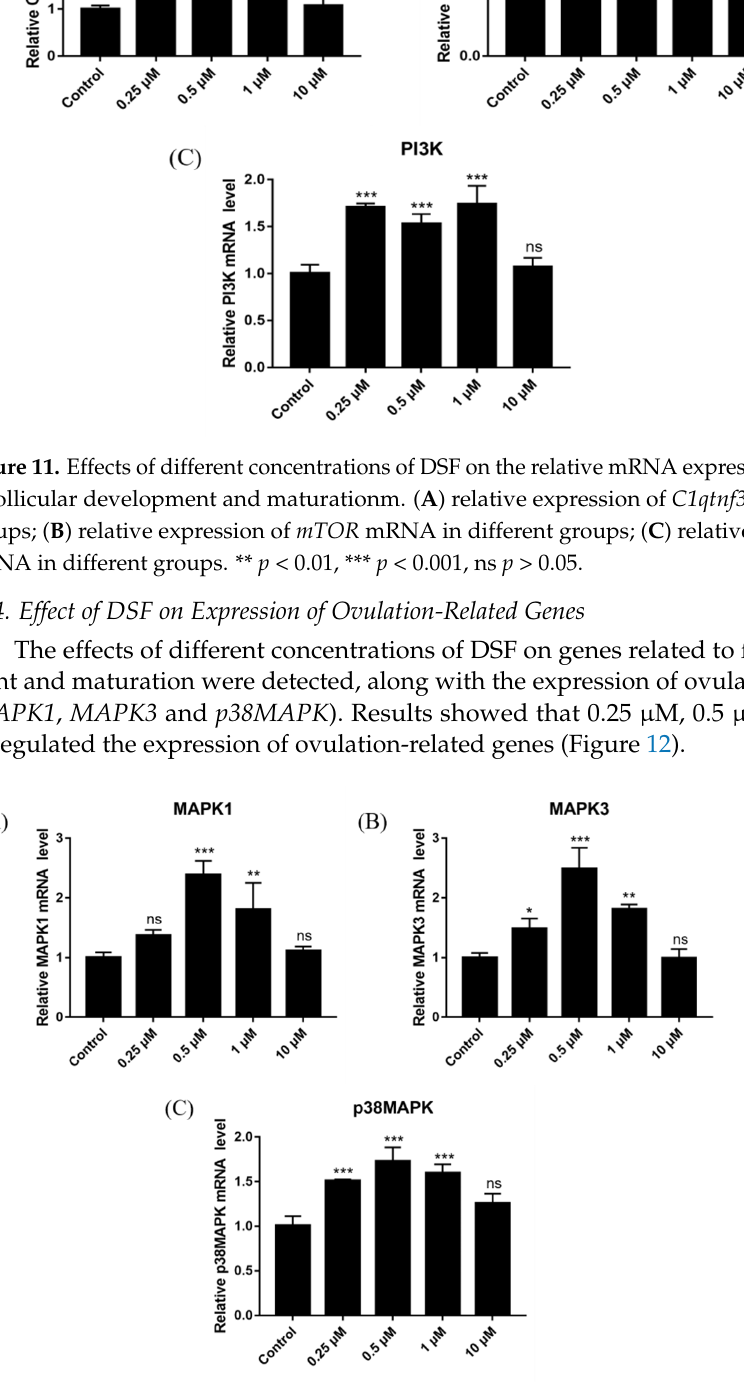
Figure 12. Effects of different concentrations of DSF on the relative mRNA expression of ovulation- related genes. ( A ) relative expression of MAPK1 mRNA in different groups; ( B ) relative expression of MAPK3 mRNA in different groups; ( C ) relative expression of p38MAPK mRNA in different groups. * p < 0.05, ** p < 0.01, *** p < 0.001, ns p > 0.05.